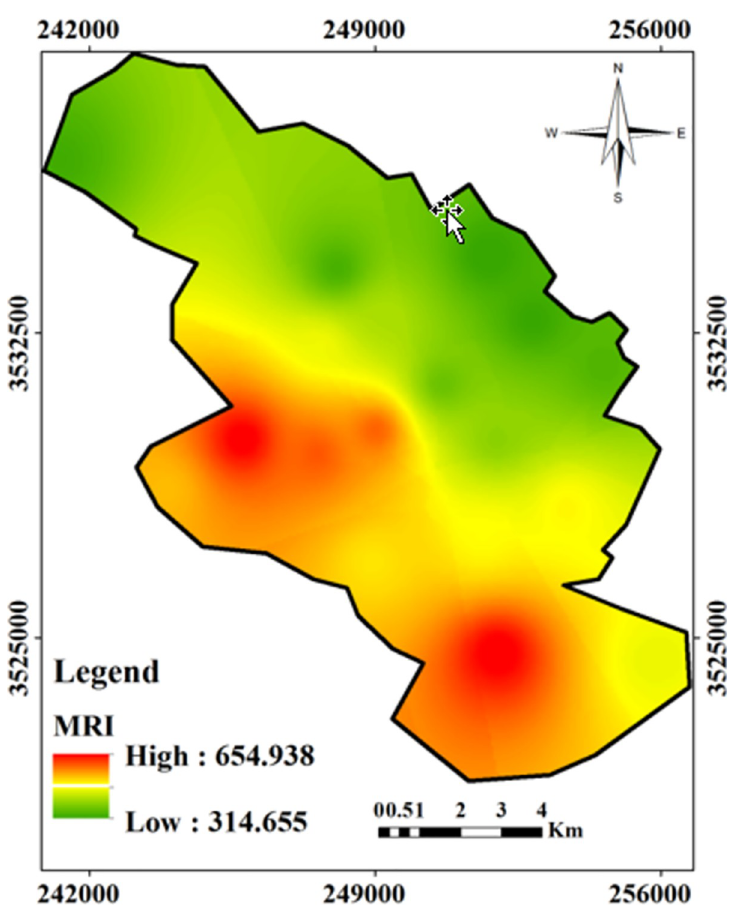
Fig 8. The spatial distribution of the Modified potential ecological risk index (MRI) in urban soil of Yazd city.